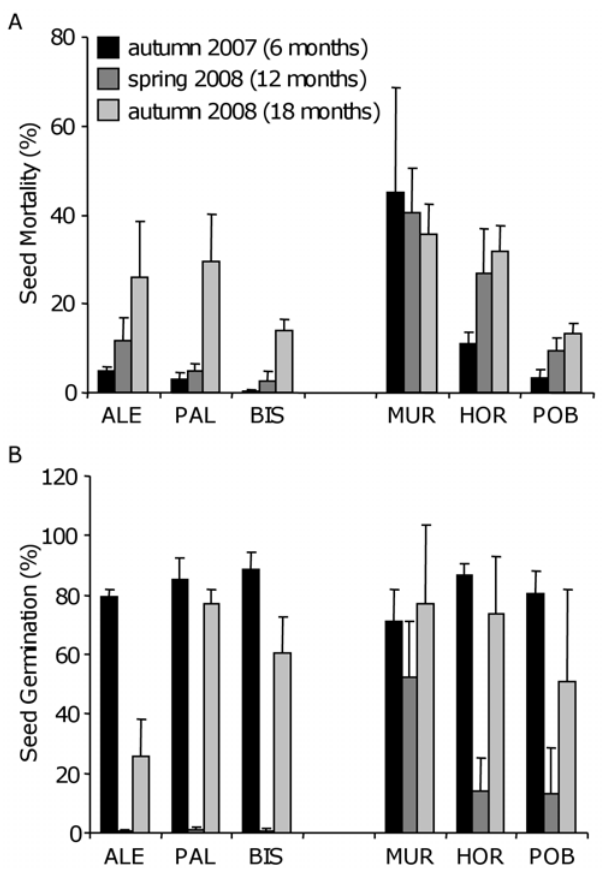
Figure 4. Persistence and germination of seeds buried in the soil seed bank. The twopanels show mean ( 6 SE) values of (A) percent seed mortality and (B) percent seed germination of the soil seed bank experiment conducted on montane (ALE, BIS, and PAL) and coastal (HOR, MUR and POB) A. thaliana populations. Seeds were collected and buried in local populations in spring 2007 and retrieved periodically every six months: autumn 2007, spring 2008, and autumn 2008.